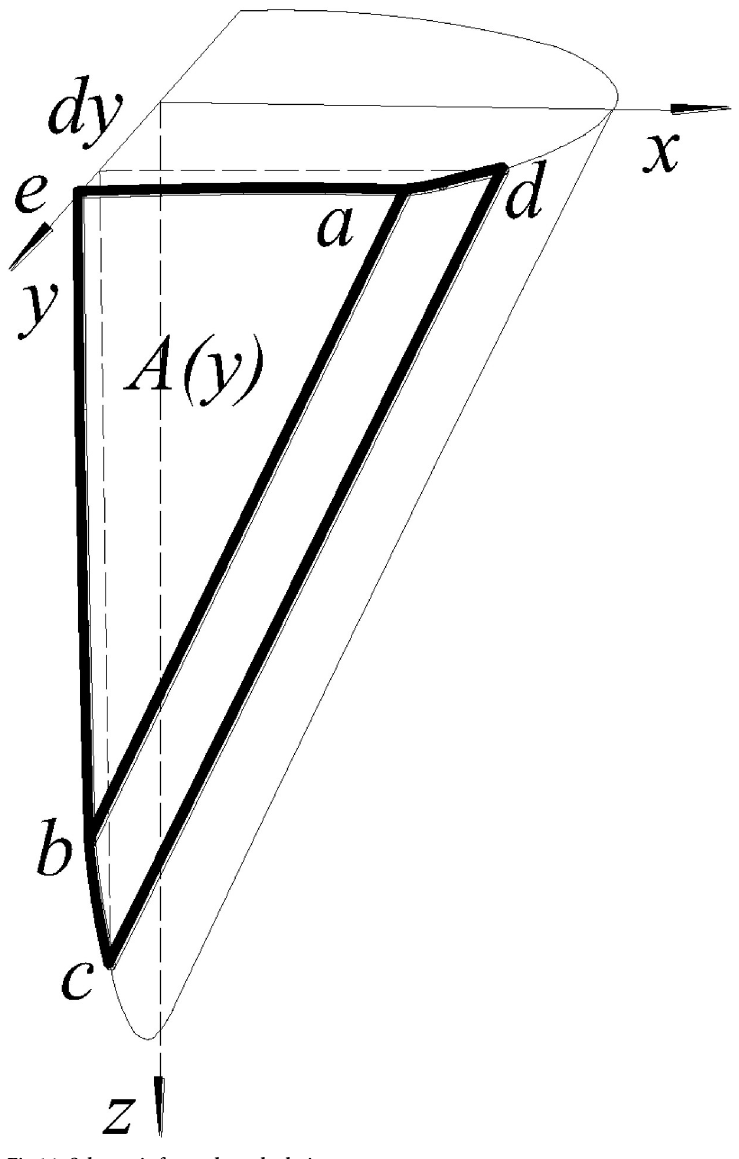
Fig 14. Schematic for wedge